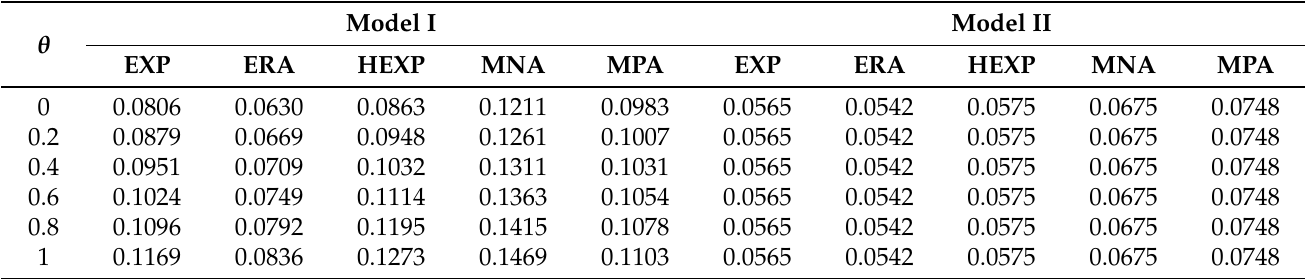
Table 3. Effect of θ on expected number of P 1 customers in the system (when L = 3).